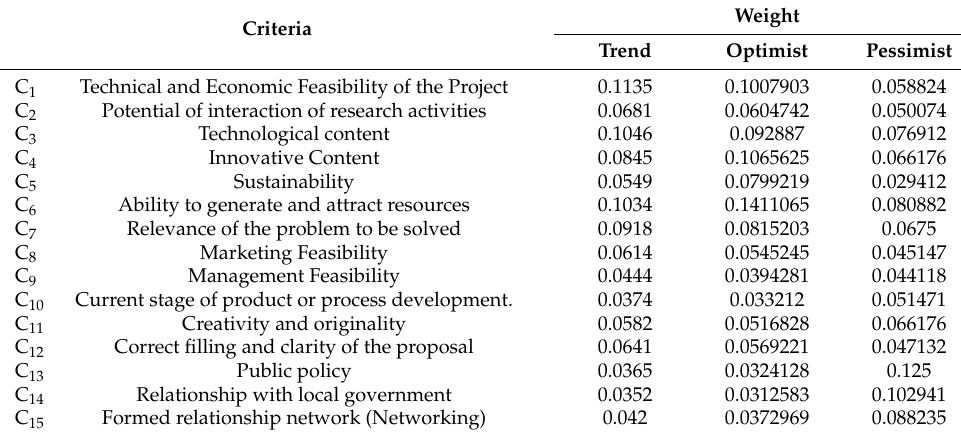
Table 13. Weights of criteria.